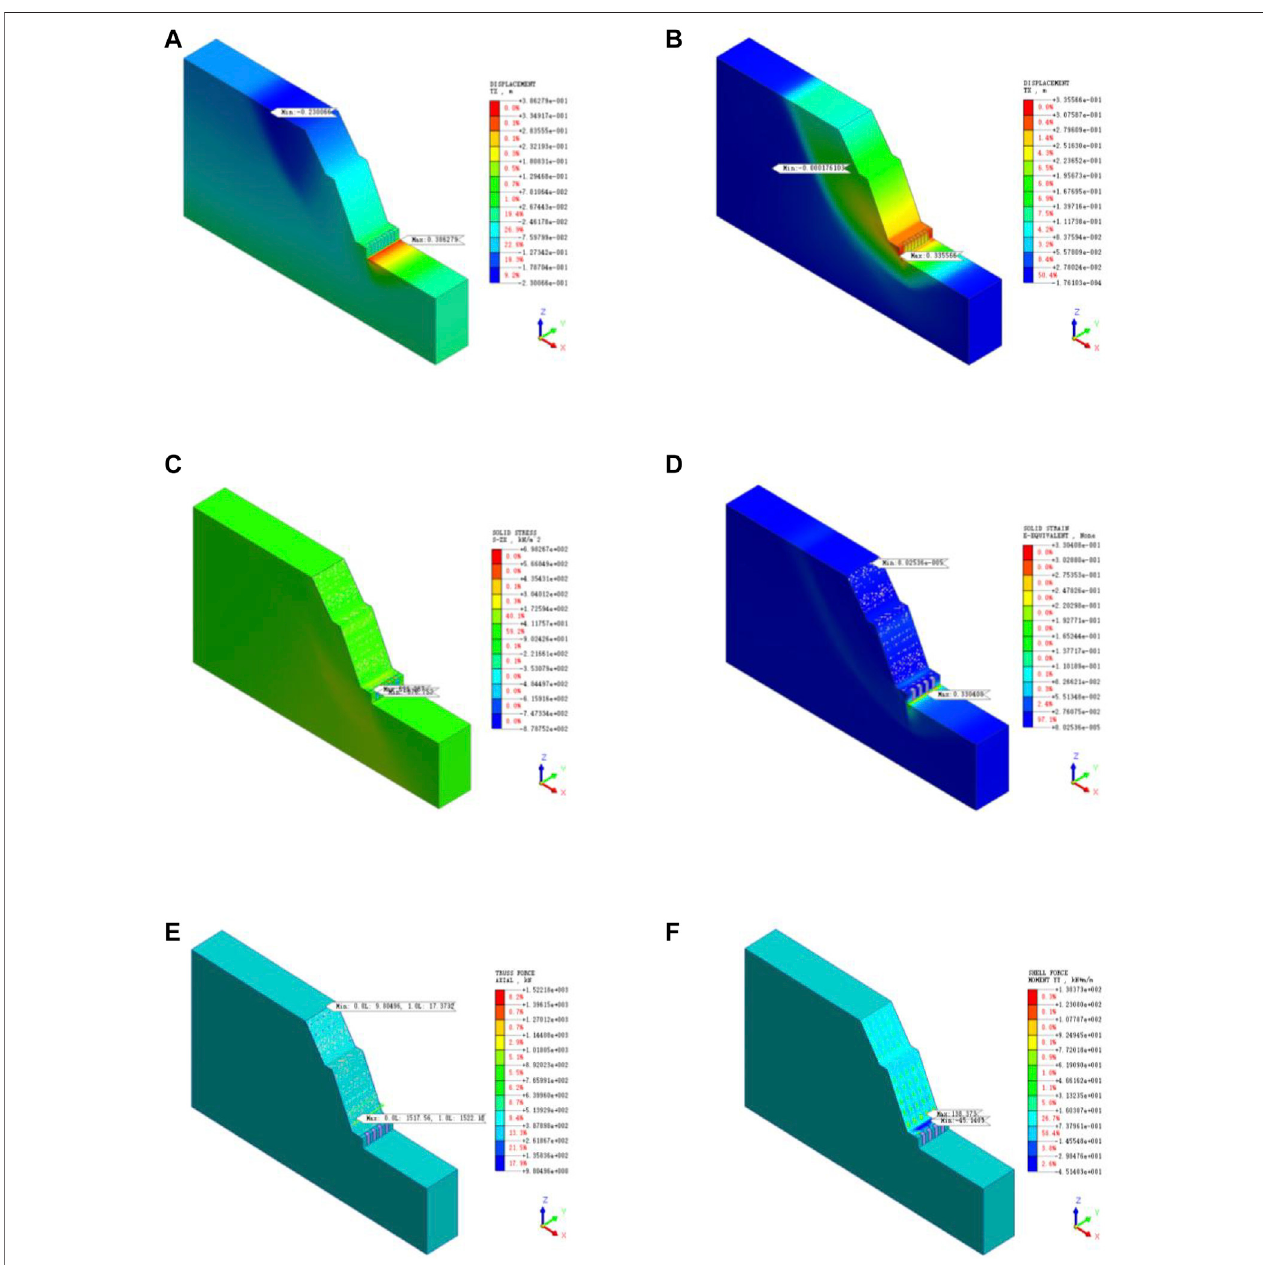
FIGURE 12 | Calculation results of rock-slag slope after construction of supporting structure: (A) vertical displacement diagram of whole-rock slag support; (B) horizontal displacement diagram of whole-rock slag support; (C) strain diagram in XZ plane after rock cinder slope construct support; (D) plastic strain diagram of rock- slag slope after construct support; (E) axial diagram of anchor bolt after construct support of rock cinder slope; (F) bending moment diagram of shotcrete on rock-slag slope.